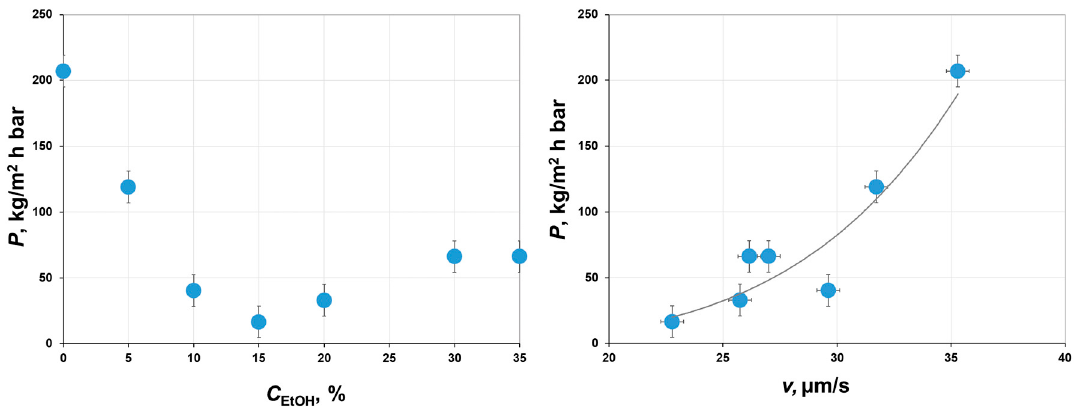
Figure 10. E ff ect of ethanol concentration in casting solution C EtOH (left) and the average precipitation rate v (right) on permeance of water-rich iso-butanol solution through the corresponded membranes.